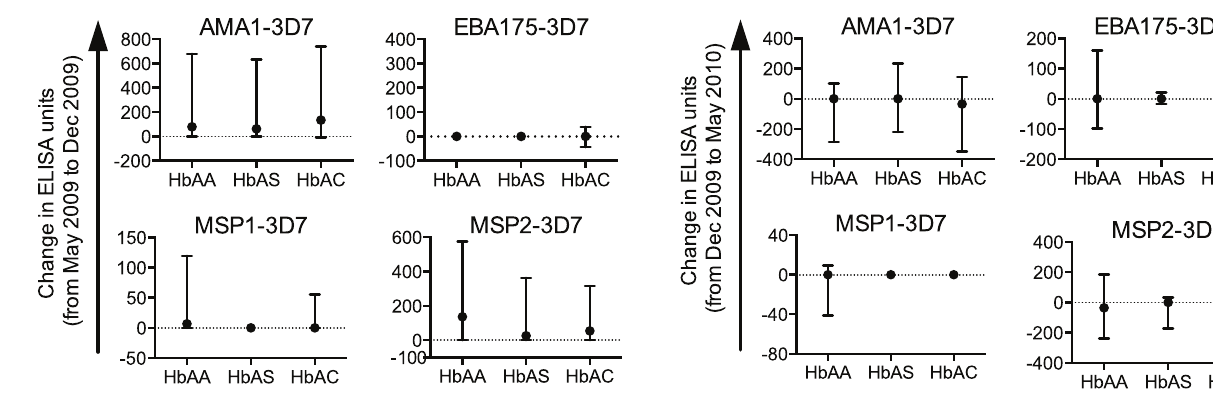
Figure 5. Merozoite antigen-specific IgG levels do not decay during a dry season, regardless of Hb type. For each child, the change in IgG level from December 2009 to May 2010 was calculated for each antigen (A, AMA1-3D7; B, MSP1-3D7; C, EBA175-3D7; D, MSP2- 3D7). All responses below the limit of detection (44 ELISA units) were assigned a value of 22 ELISA units. Median and interquartile range are shown. Positive values represent increases in IgG levels at the end of the dry season. Changes in IgG levels were not significantly different among the three Hb types for any antigen (p . 0.05 by Kruskal-Wallis